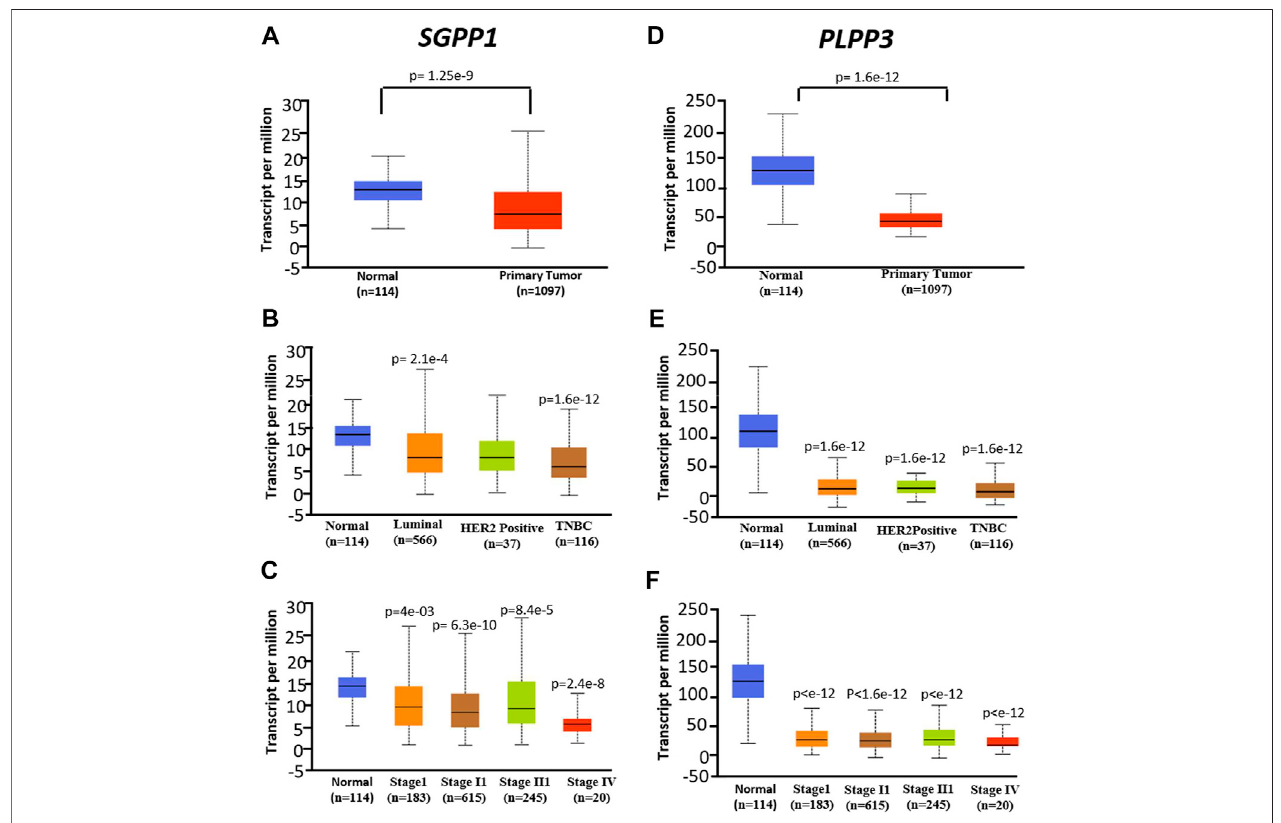
FIGURE 4 | mRNA expression was analyzed in normal tissue (N (cid:2) 114) and primary tumors from breast cancer (N (cid:2) 1,097) patients from the publicly available UALCAN database. (A – C) , SGPP1 (where A (cid:2) normal vs. tumors, B (cid:2) normal vs. cancer subtypes and C (cid:2) normal vs. tumors of different stages). * p < 0.01 Stage I vs StageIV,StageIIvsStageIVandStageIIIvsStageIV. (D – F) , PLPP3 (whereD (cid:2) normalvs.tumors,E (cid:2) normalvs.cancersubtypesandF (cid:2) normalvs.tumorsofdifferent stages). Data are shown as average number of transcripts per million. p values are calculated for primary tumors vs. normal tissues in corresponding